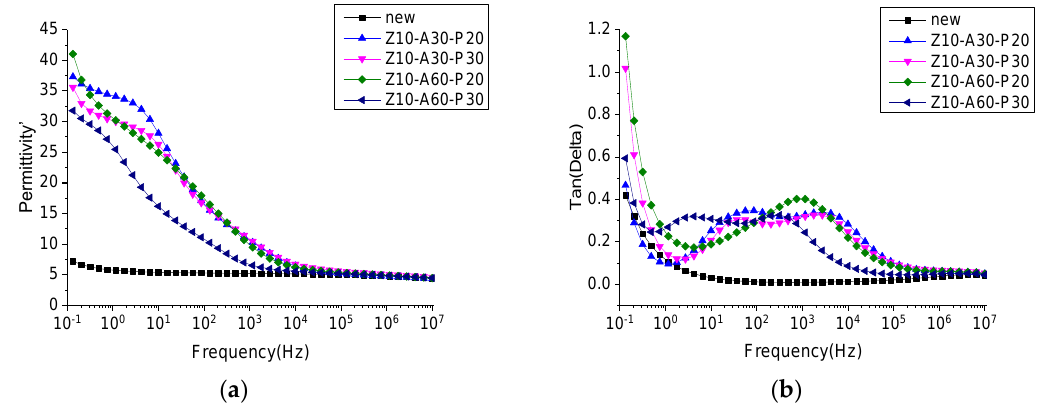
Figure 11. Frequency dielectric spectrum ( a ) and dielectric loss spectra ( b ) of the untreated insulating pressboard and modified insulating pressboard.